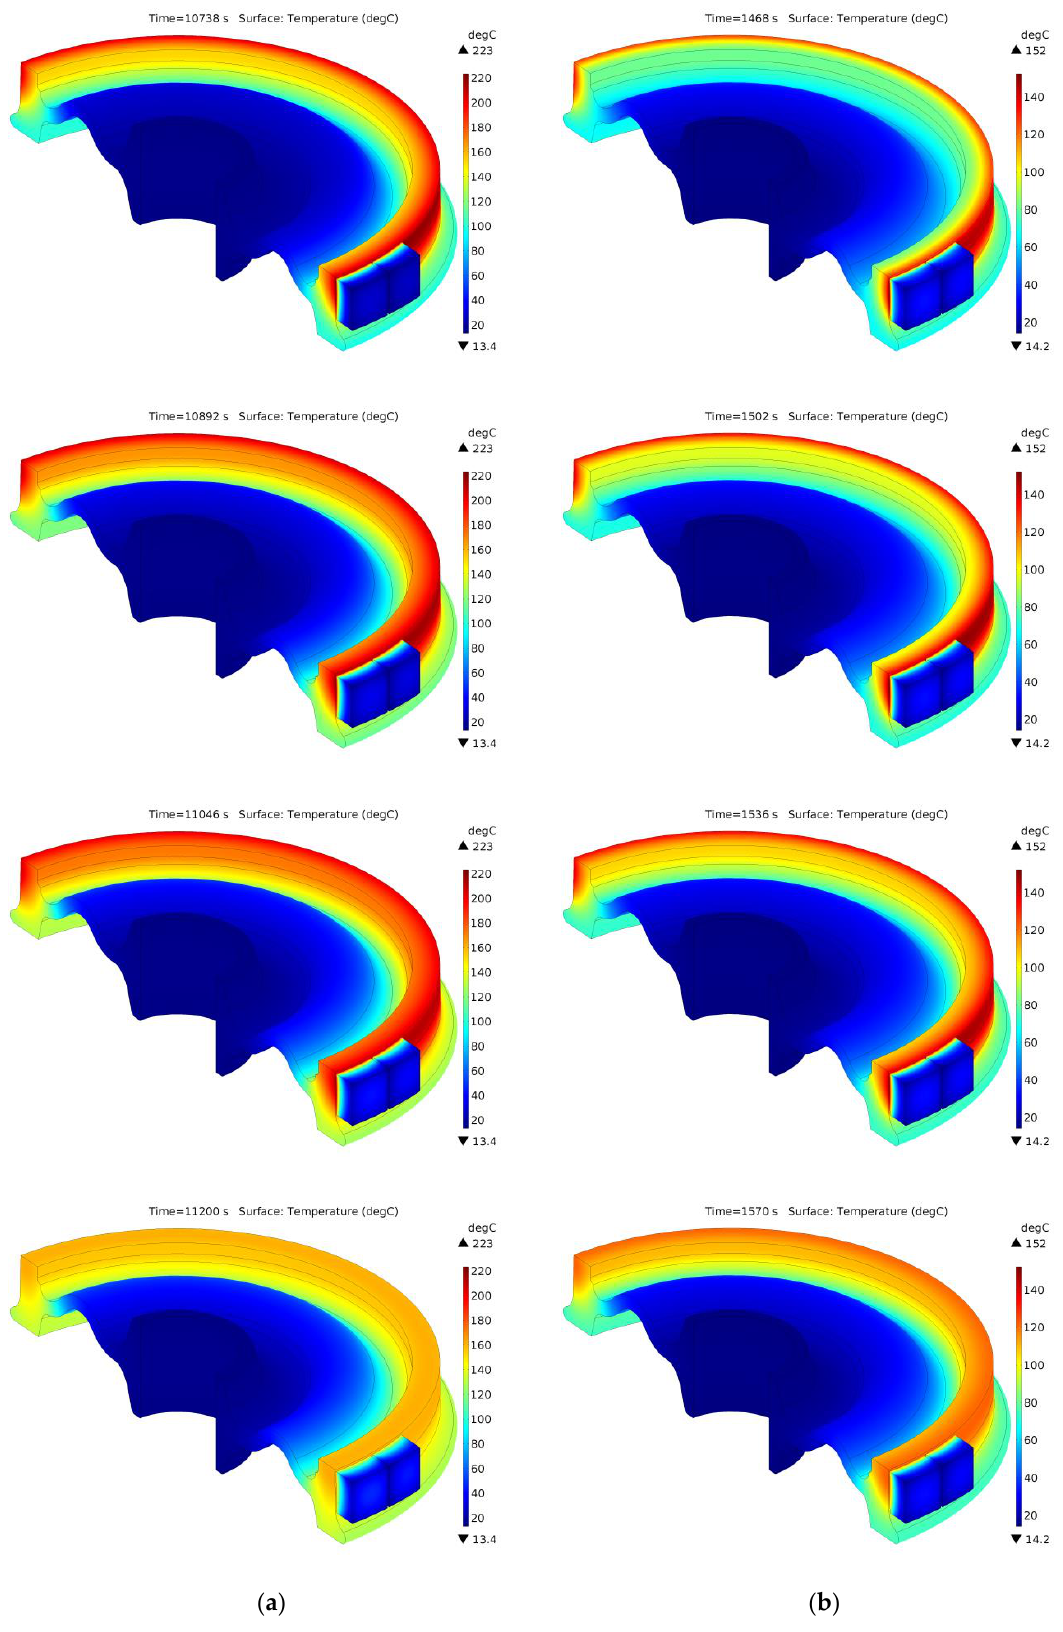
Figure 10. Temperature distribution in the wheel and brake shoe for selected time points marked in Figure 9a,d, for braking no. 7: ( a ) Material A/ER7; ( b ) Material B/ER7.